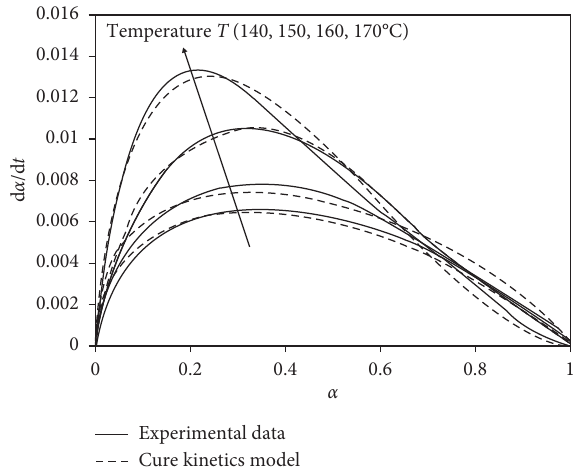
Figure 3: The rate of cure values (d α /d t ) as a function of cure degree evaluated at different temperatures ( ― experimental data; --- curve generated by cure kinetics model).